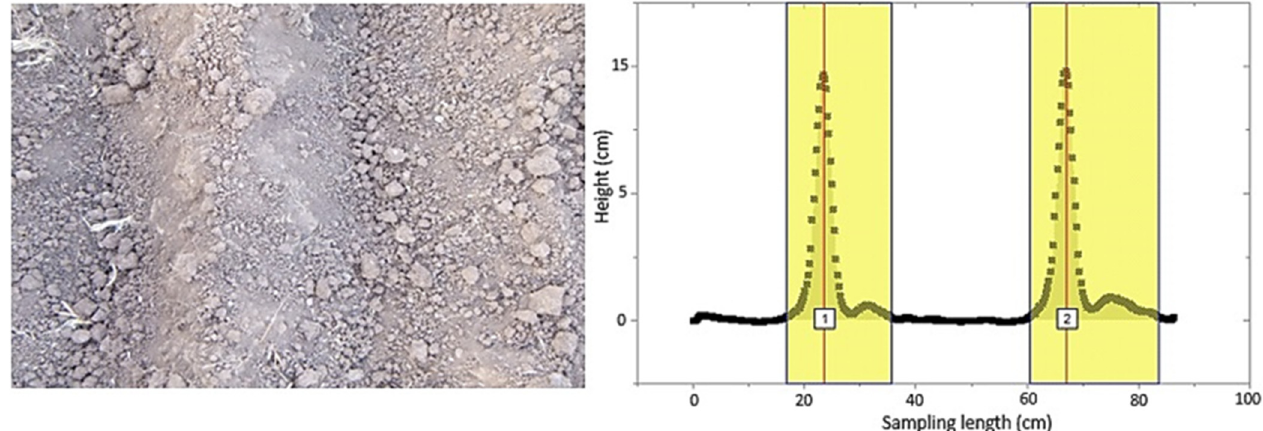
Figure 8. The original image of the surface of a plowed soil with the detection of peaks corresponding to the plow layers.